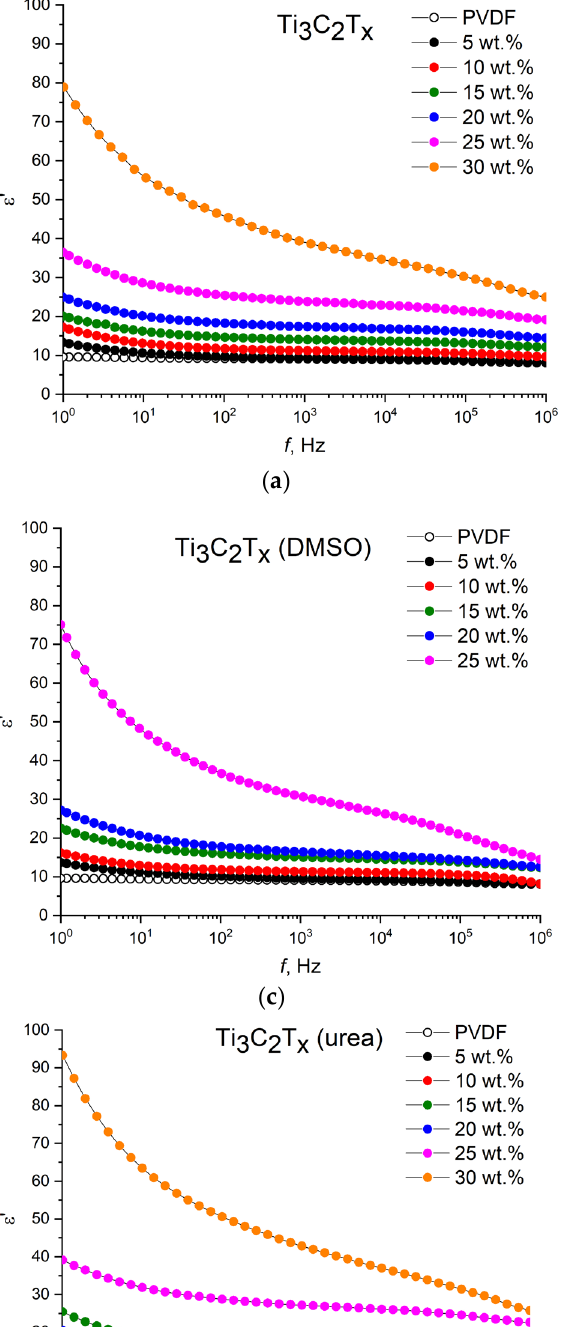
loading of 20 wt.%.